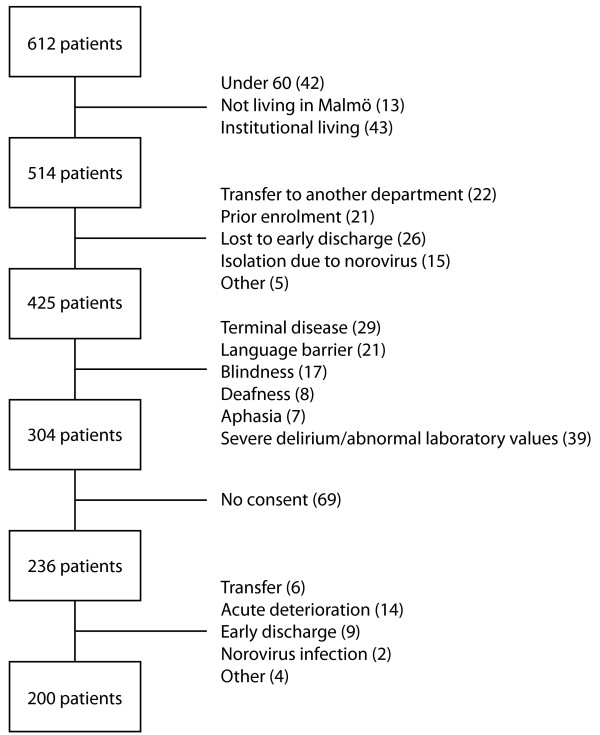
Patient flow showing exclusion criteria.